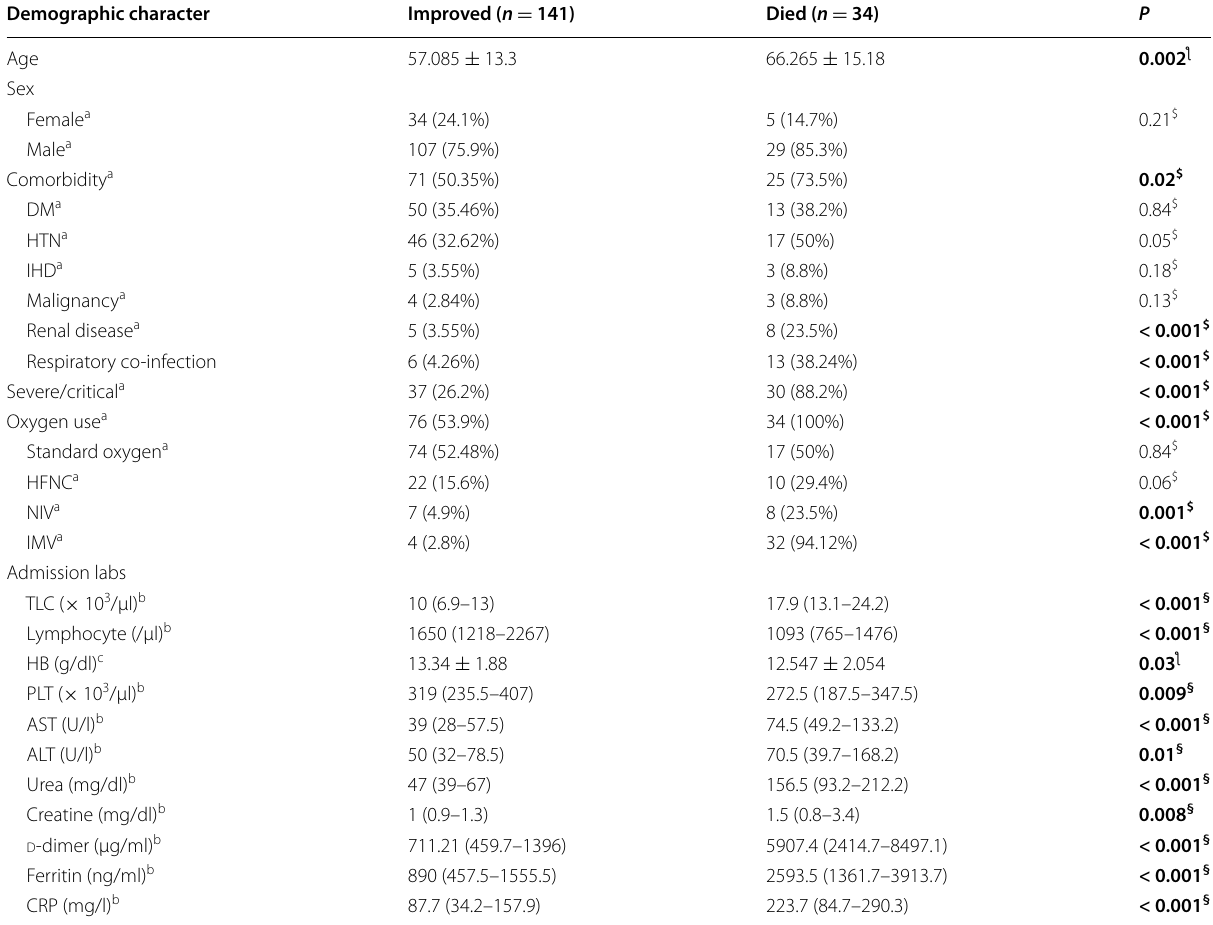
Table 4 Univariate Cox analysis of COVID‑19 risk factors for mortality